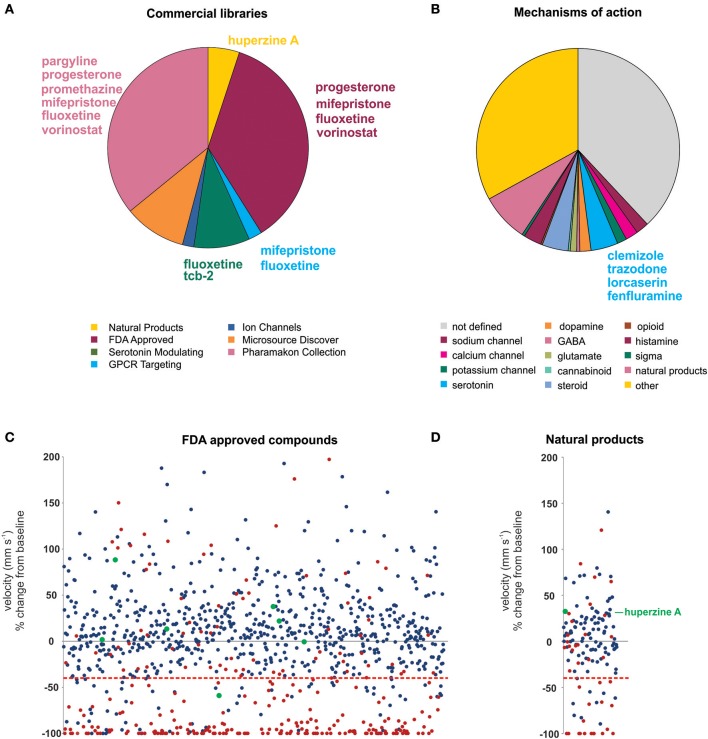
Summary of the compound screening results using the scn1labs552 homozygous mutant larvae to identify drugs for DS. Using our pharmacologically validated dual-stage assay screening protocol, 2,863 compounds have been blind tested for anti-seizure activity in the scn1labs552 homozygous zebrafish larvae. (A) Seven commercially sourced drug libraries were screened including the MicroSource Discovery Systems' International Drug Collection (Baraban et al., 2013) and Pharmakon Collection (Dinday and Baraban, 2015) and Selleckchem's, ion channel library, GPCR compound library, a serotonin modulating compound library (Griffin et al., 2017), a natural product library and a FDA-approved compound library. Compounds highlighted in this plot were reported by other groups as being effective anti-seizure compounds, but could not be confirmed as such in our hands. Specifically, these compounds failed to induce an antiepileptic response when screened blinded as part of these commercial libraries. Blind screening of libraries allows for unbiased testing of compounds regardless of their mechanism of action. (B) A summary of identified mechanism of actions of all compounds screened highlighting the broad range of mechanisms covered by these libraries. Clemizole, trazodone and lorcaserin effectively suppressed seizure activity in the scn1labs552 homozygous zebrafish larvae. These compounds have known activity at serotonin 2 receptors. 4.3% of all drugs tested are known to modulate serotonin signaling, however, only these drugs were effective. The serotonin reuptake inhibitor fenfluramine is also effective in suppressing scn1labs552 homozygous larvae seizure activity and is currently in clinical trial for DS. (C) The FDA approved compound library, and (D) natural product library were also screened for compounds inhibiting seizure activity. Plots show the locomotor seizure behavior for 5 dpf scn1labs552 mutants during the first stage screening. The threshold for inhibition of seizure activity (positive hits) was determined as a reduction in mean swim velocity of 40% (red line). Red data points represent compounds that were classified as toxic as treated larvae have no visible heartbeat or movement in response to touch after 90 min exposure. Green data points represent known AEDs. The natural product huperzine A which has been shown to be effective against hyperthermia induced seizures is labeled. No additional lead compounds were identified in these libraries.